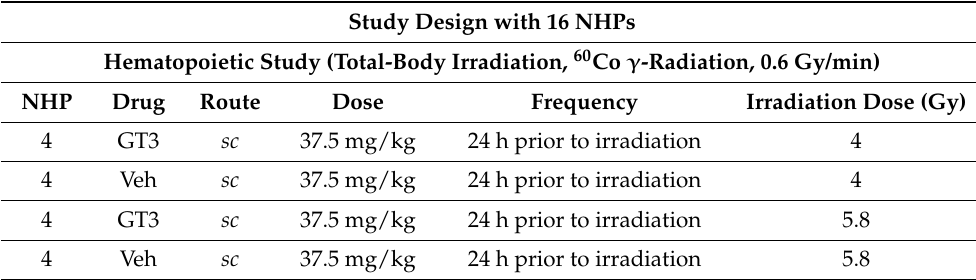
Table 1. Experimental design for 16 NHPs exposed to 4 and 5.8 Gy TBI. Study Design with 16